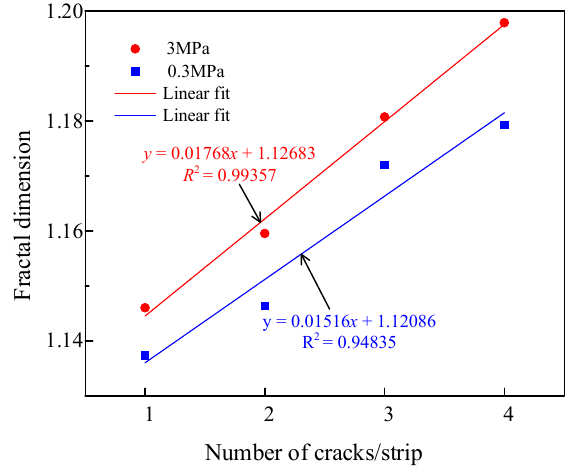
Figure 11. Relationship between fractal dimension and crack number.